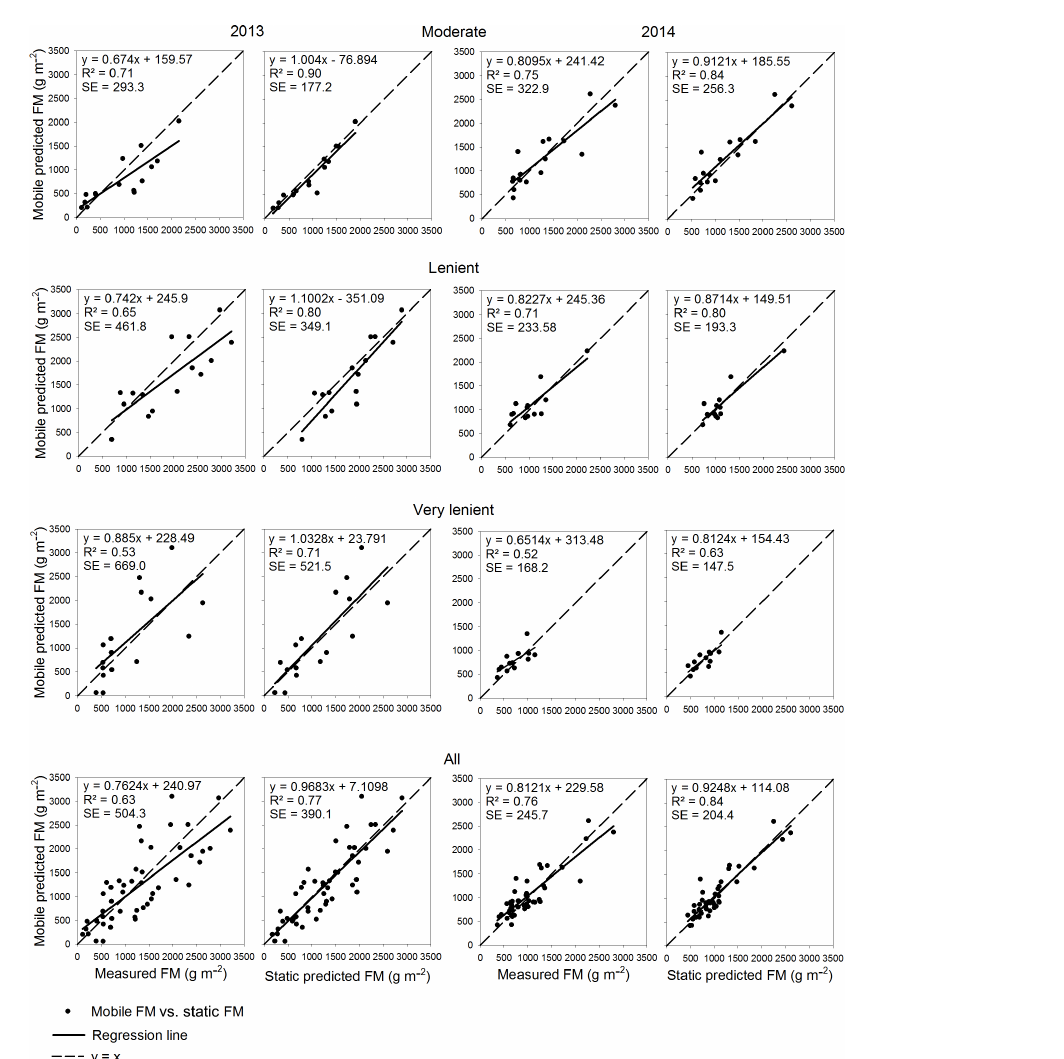
Figure 5. Relationship between mobile- and statically measured biomass (g FMm − 2 ; based on combined sensor data USH and NDSI) and values measured by clipping. All measurements were conducted on reference plots in pastures differently stocked with animals in 2013 and